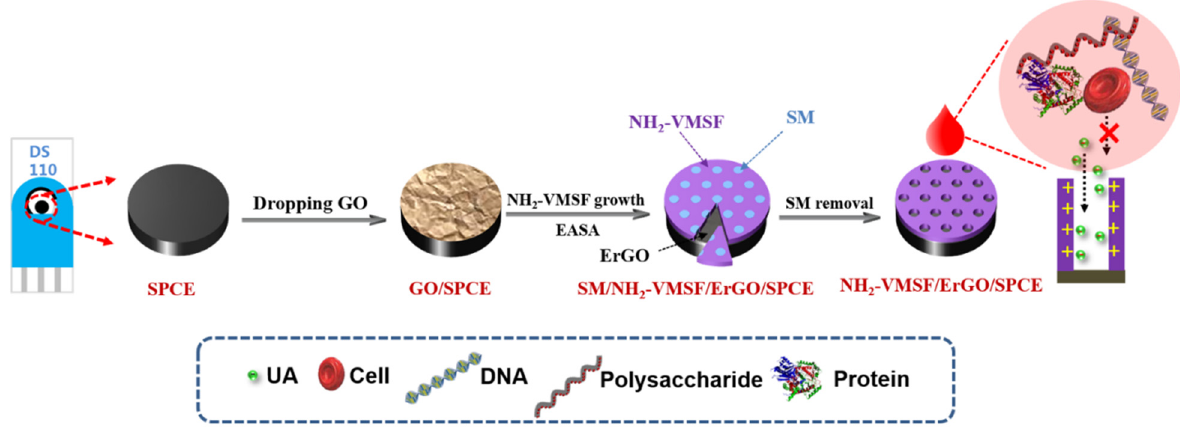
Figure 1. Schematic illustration of the stable coupling of NH 2 -VMSF with SPCE using ErGO as an adhesive layer and direct detection of human whole blood.